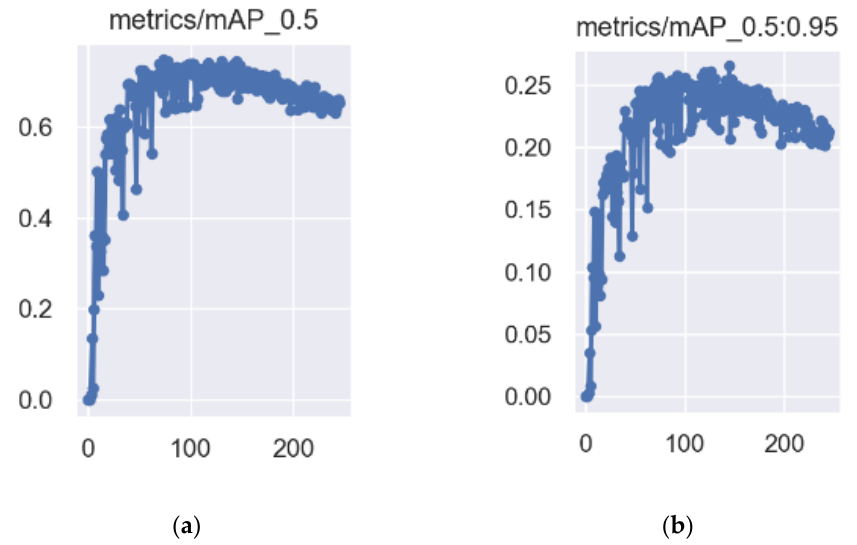
Figure A11. The precision/recall curve and F 1 Score /confidence curve of YOLOV5l: ( a ) PR_curve; ( b ) F1_curve.